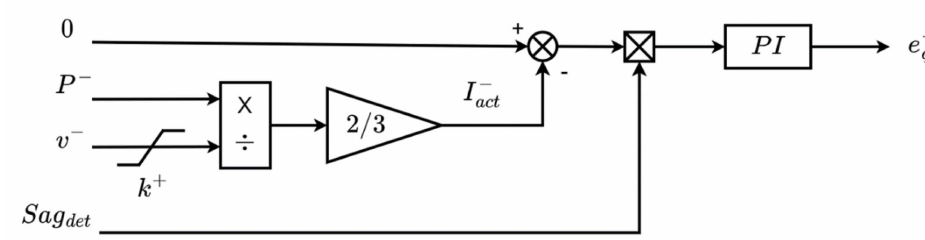
Figure 12. Negative active current controller block.